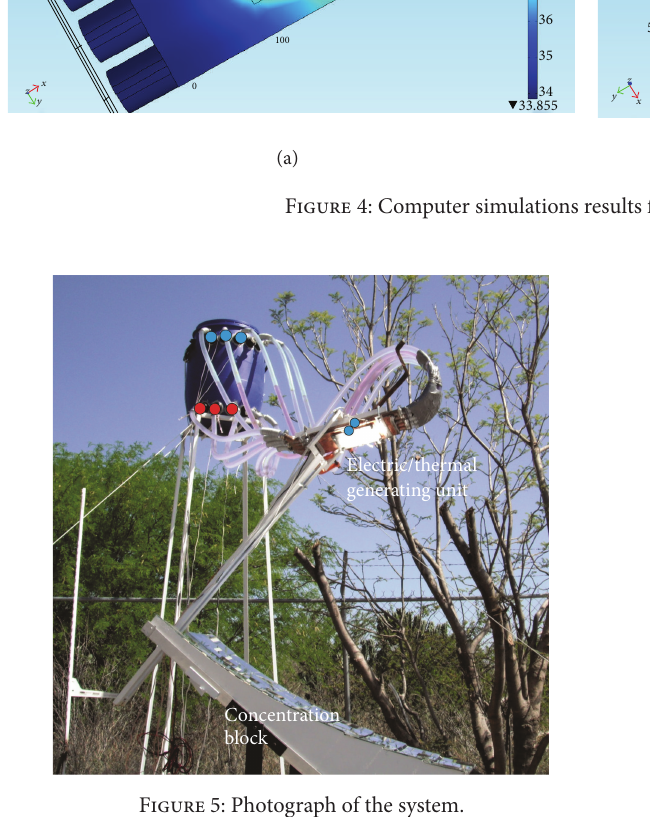
Figure 5: Photograph of the